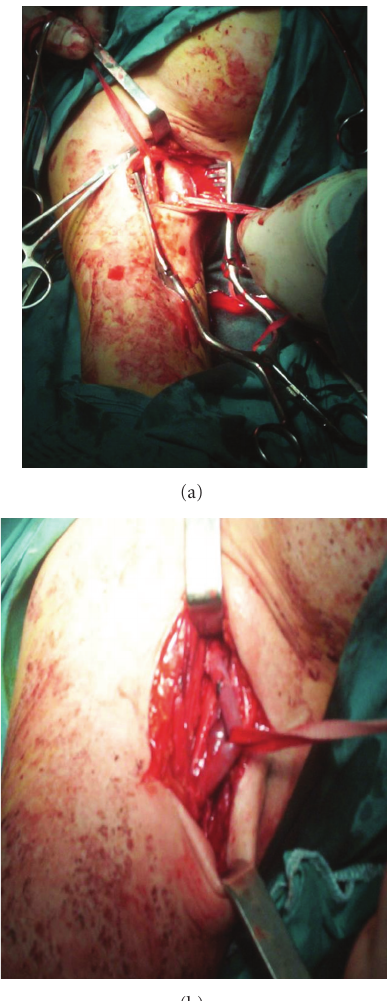
Figure 2: The aneurismal segment was resected and a saphenous vein graft was interposed between the two transected segments of axillary